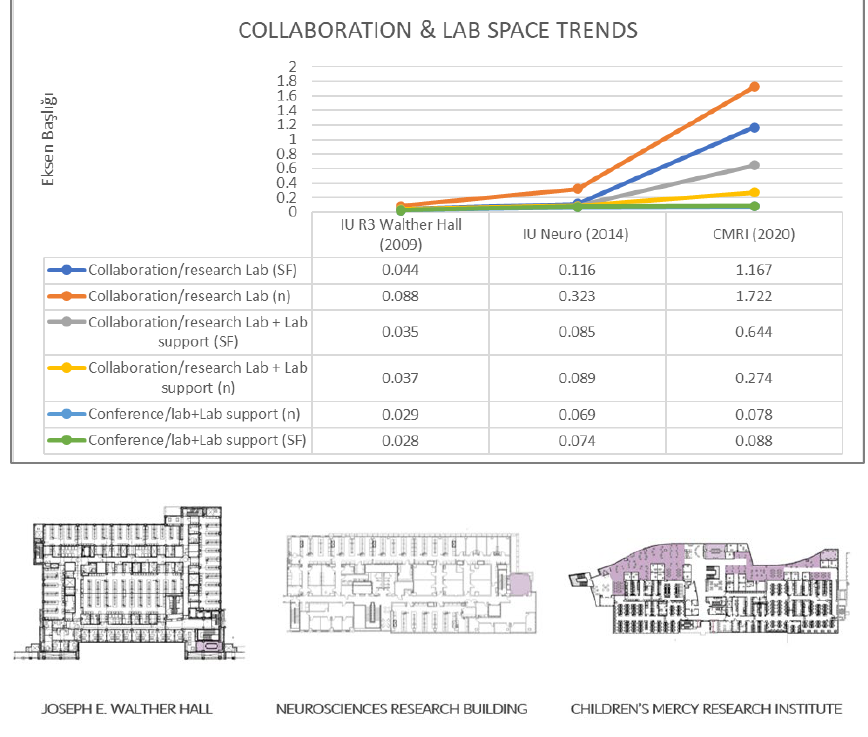
Figure 9 Relationship between collaboration and research lab quantity and size over